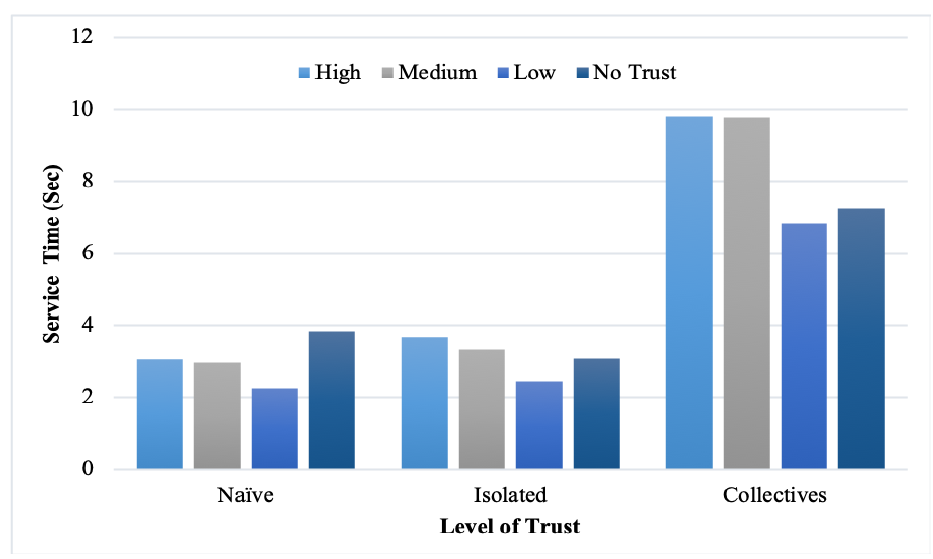
Figure 8. MAD result with feedback malicious collectives.